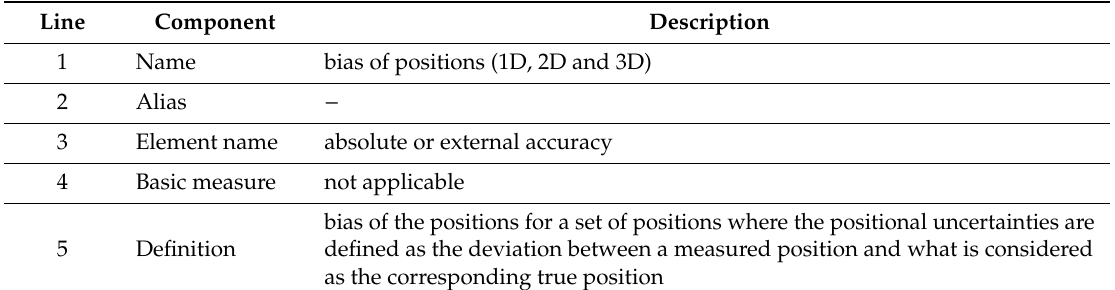
Table 8. Standardized data quality measure—bias of